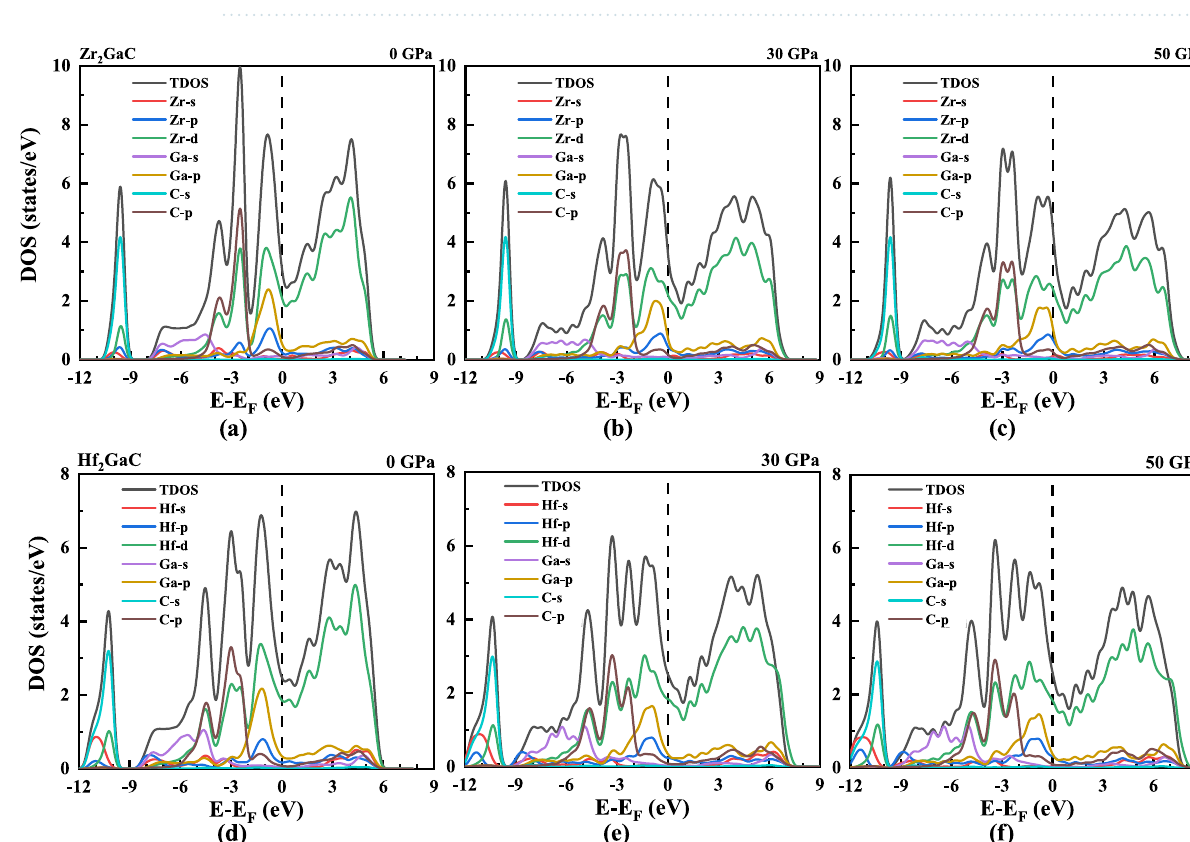
Figure 5. The total and partial density of states (PDOS) for Zr 2 GaC at pressure a 0 GPa, b 30 GPa, and c 50 GPa, and for